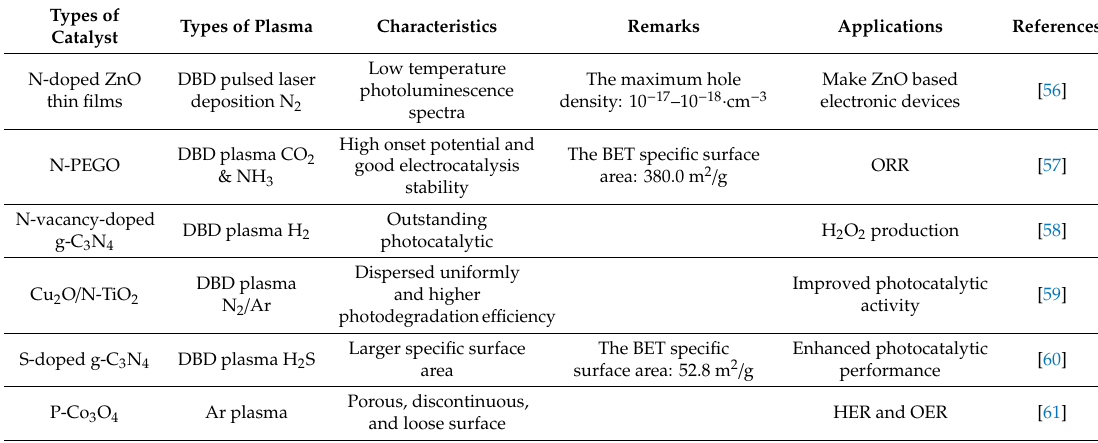
Table 3. Heteroatom-doped catalysts prepared by a plasma technique.